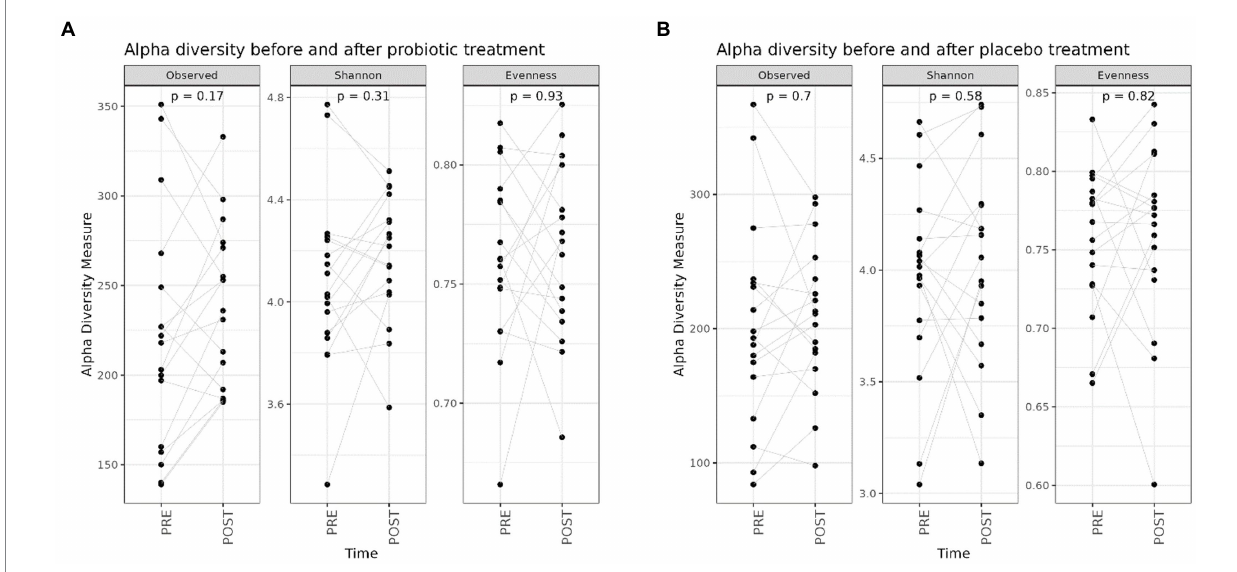
FIGURE 1 Box plots reporting alpha diversity indices (Observed ASV richness, Shannon index, Pielou’s evenness) pre- ( n = 20) and post-probiotic ( n = 20) (A) and pre- ( n = 20) and post-placebo (n = 20) (B) treatments. Lines link paired samples and statistical differences were assessed using the Wilcoxon signed- rank test. p -values less than 0.05 were considered statistically significant.